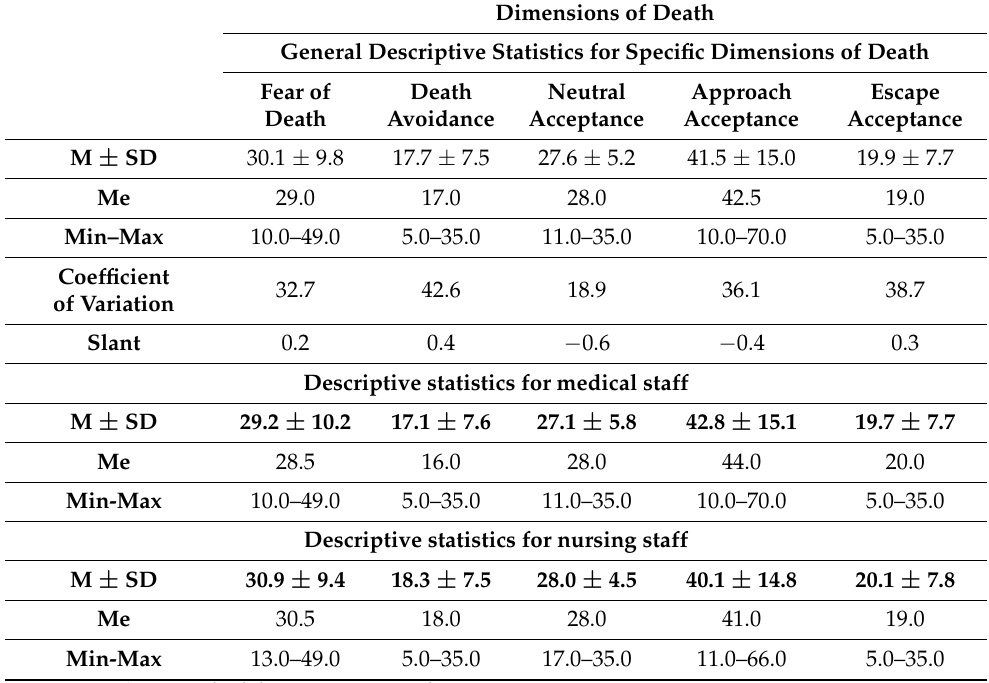
Table 2. Selected descriptive statistics for individual death dimensions according to DAP-R-PL.